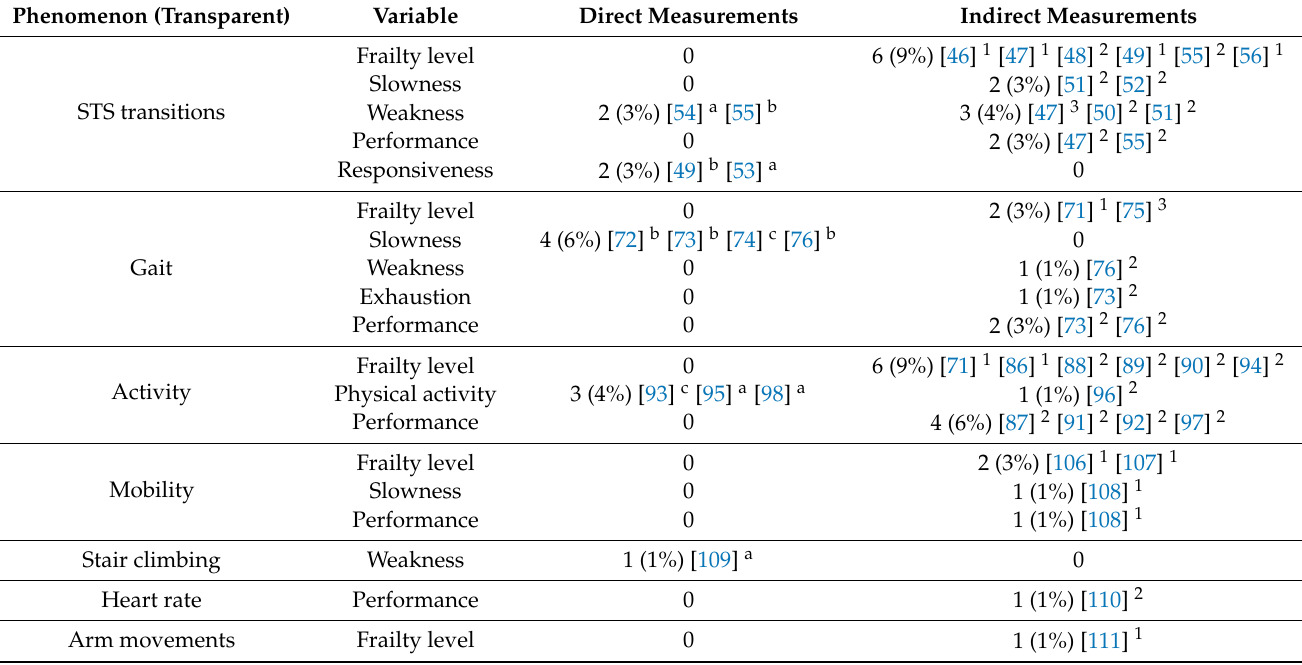
Table 9. Relationships between sensor outcomes (left column) and the target functional variables (second column on the left) for studies relying on transparent activities. Studies where the outcome parameters act as a direct measurement for the value of the target variable are listed in the second column on the right. Studies where the outcome parameters act as an indirect measurement for the value of the target variable are listed on the right column. The figures in square brackets are the citations for the corresponding studies. The figures in brackets represent the percentage with respect to all 67 studies in the review.